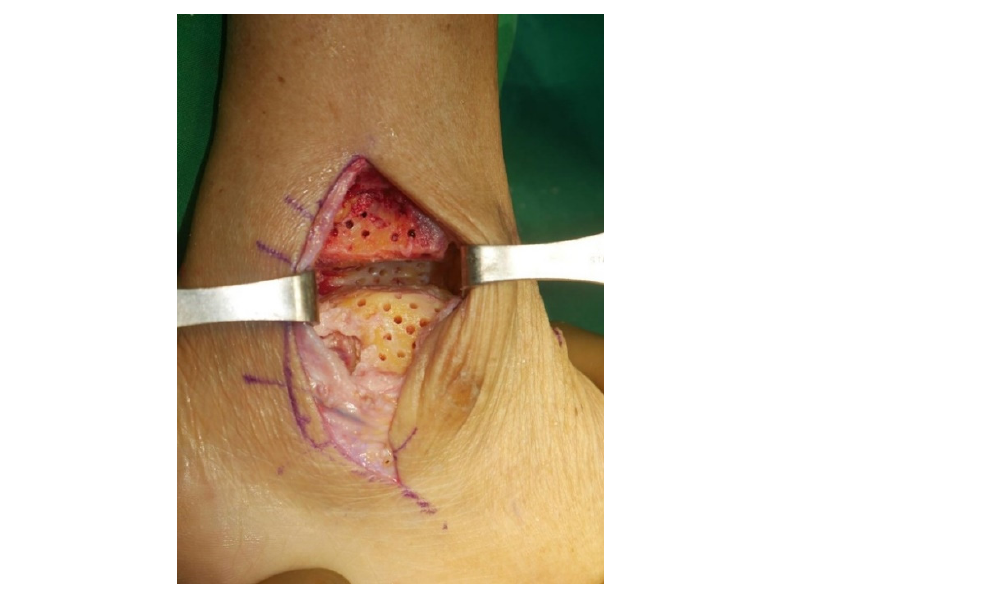
Figure 3. After exposure of the distal fibula, the fibula was transected 4 to 5 cm proximal to the ankle joint.